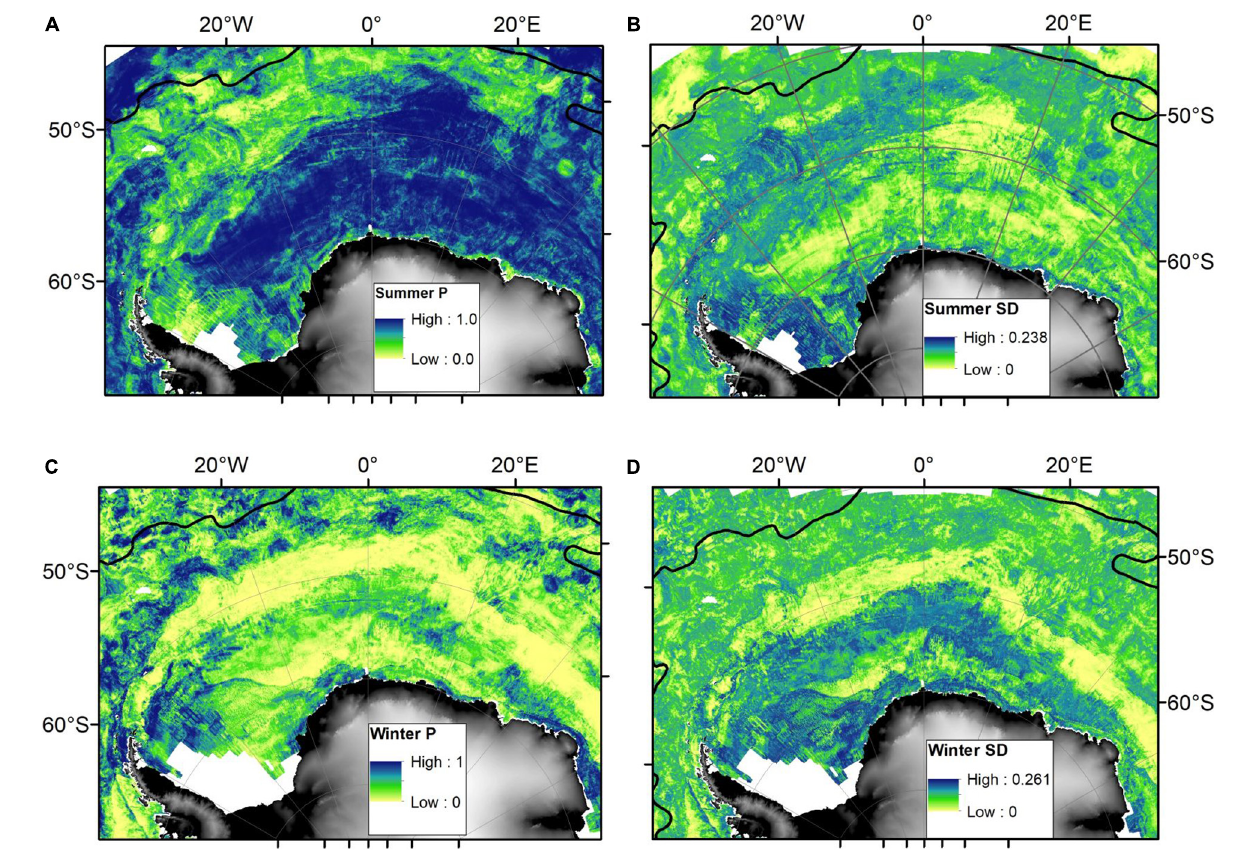
FIGURE 3 | Predicted Ross seal area-restricted search habitat for summer (A,B) and winter (C,D) , respectively illustrating the probability (P) and standard deviation (sd) of a Ross seal making use of area-restricted search behaviour across the entire Weddell Sea and adjacent waters. The black line indicates the Polar Front (Orsi et al.,